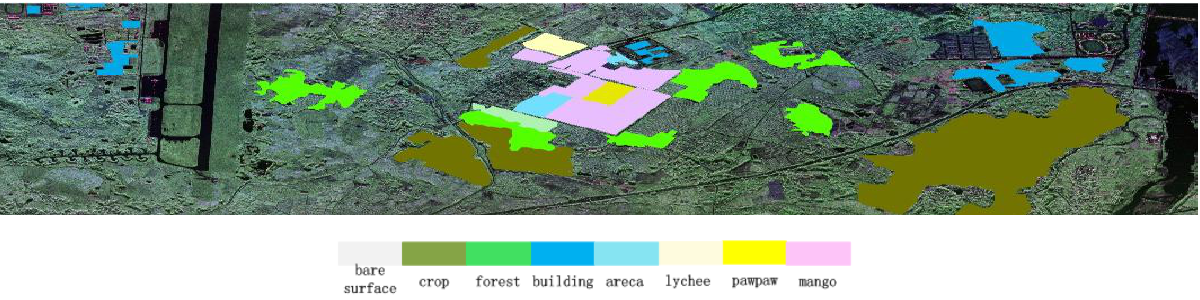
Figure.2.Ground measurements superimposed on the polarimetric color synthetized map.